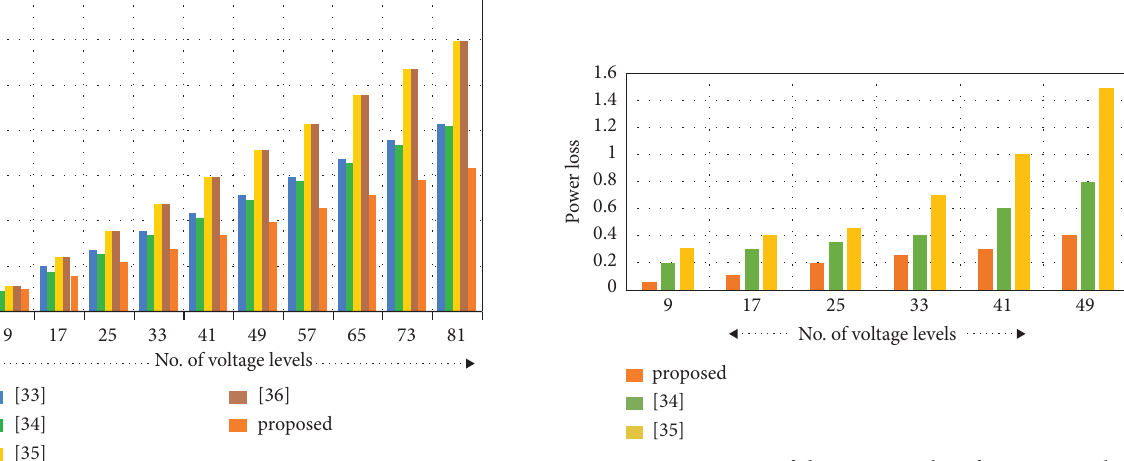
Figure 11: Comparison of number of gate drivers required for various voltage levels in recent topologies vs. proposed topology.